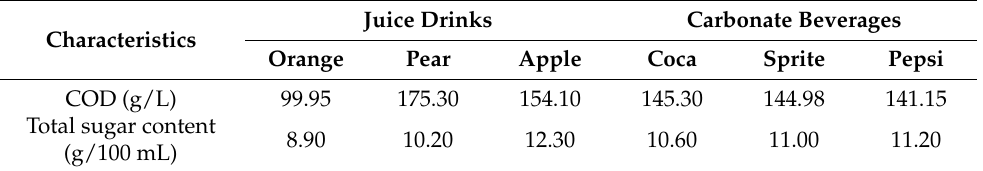
Table 2. Characteristics of sweet drinks and carbonate beverages used in this